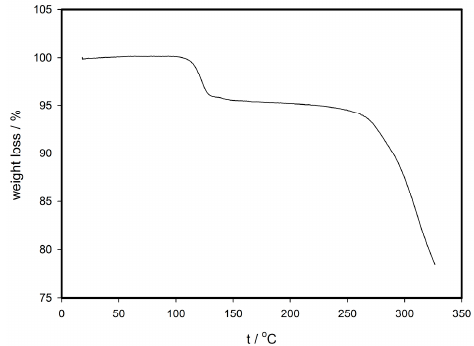
Figure 1. Thermogram of mixture sample of compounds ( 1 ) and ( 2 ).